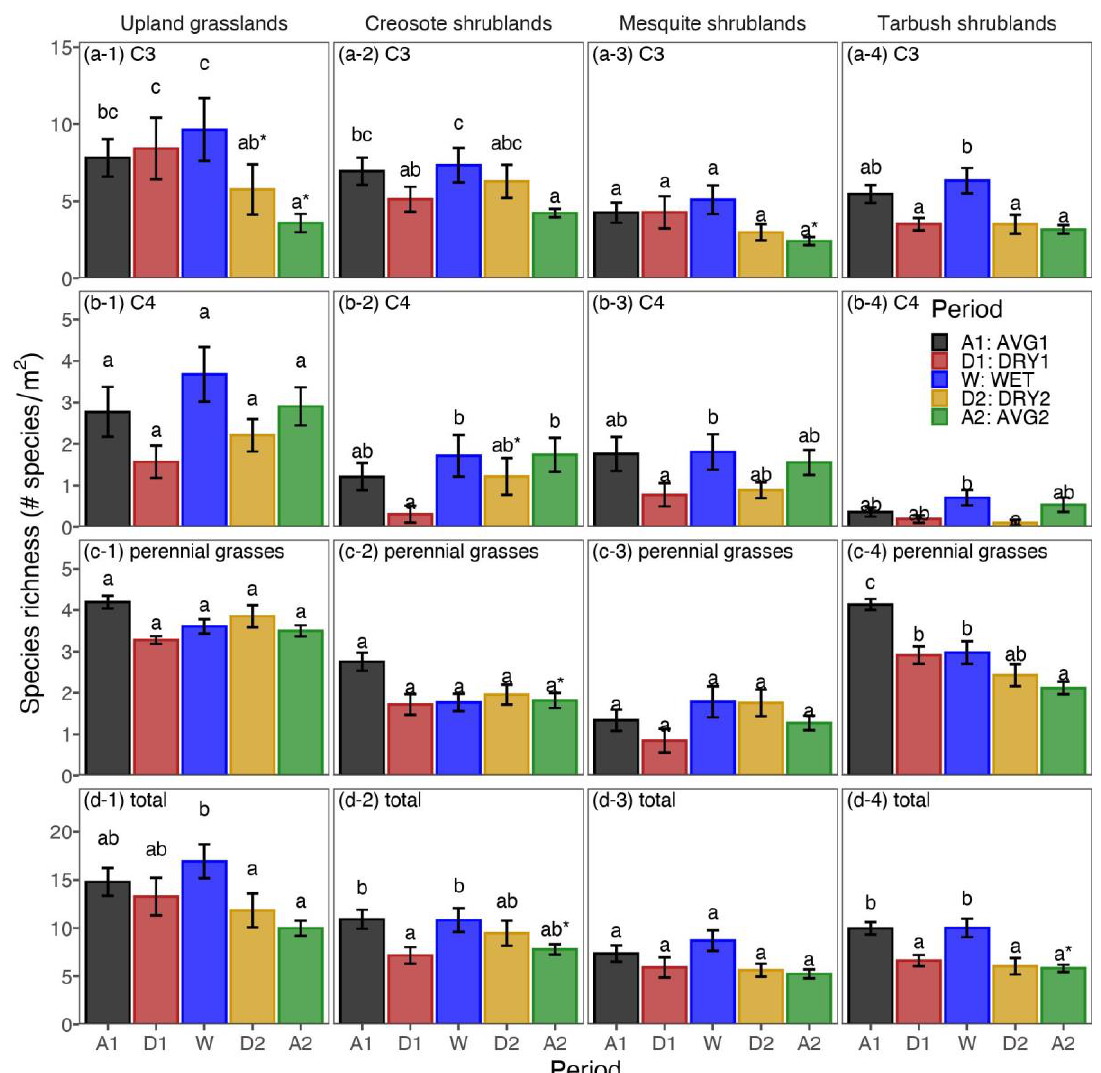
Figure 2. Species richness (number square meter) at four ecosystem types (columns, 1 – 4 ) for three functional groups and total combined (rows, a – d ). Period average richness and ±1-standard error shown. Letters indicate significantly different means in the five-way comparison of periods. Asterisks over DRY2 or AVG2 indicate significantly different means in pairwise comparisons with DRY1 or AVG1, respectively. Vertical scale differs by functional group.